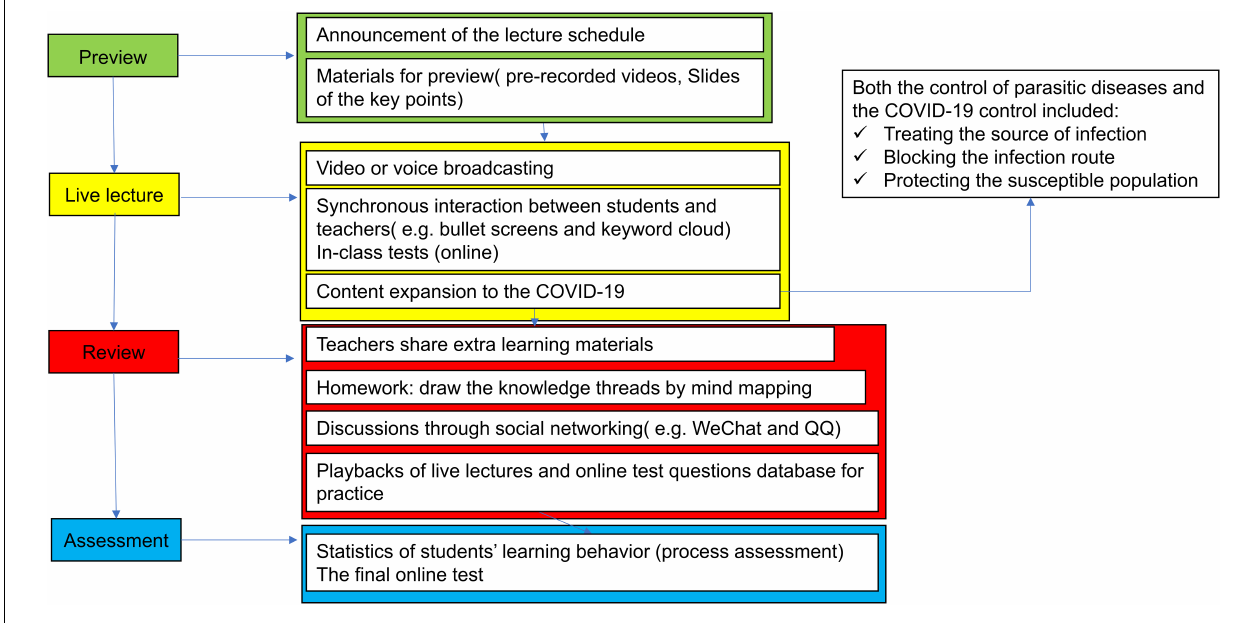
FIGURE 1 | Human parasitology online teaching model during the COVID-19